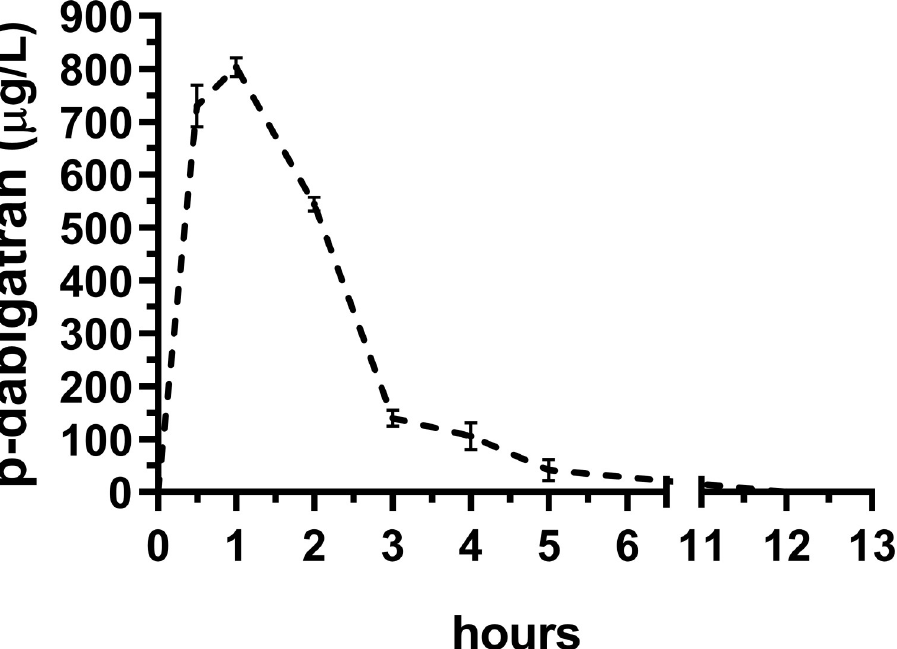
Fig 1. Dabigatran pharmacokinetics (PK). PK of dabigatran etexilate administrated by one dose of 10 mg/kg intraperitoneal. Plasma dabigatran (p-dabigatran) were measured in two healthy rats at each time point ( n = 14). A peak p-dabigatran concentration was seen after 1 hour (~800 μ g/L) and though value was seen at 5 hours (40 μ g/L).